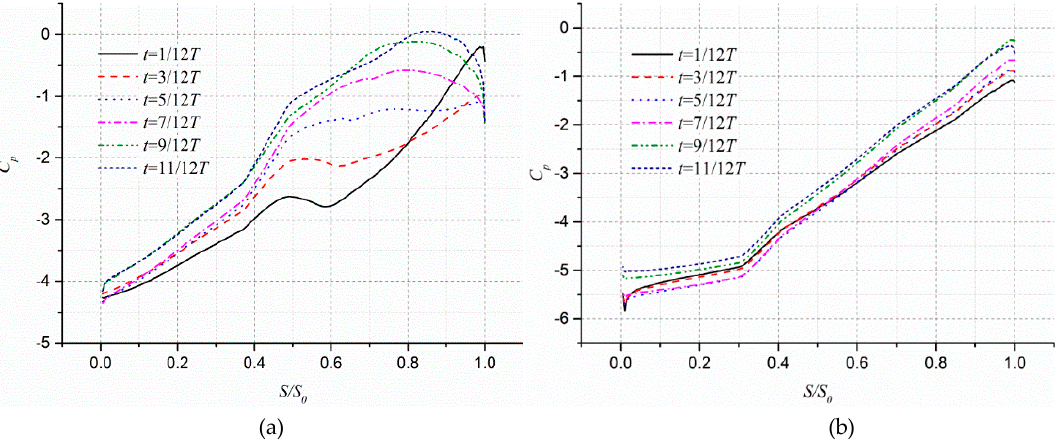
Figure 10. Distribution of the pressure coefficient on the blade surface for the Z / b 2 = 0.15 cross section: ( a ) pressure surface and ( b ) suction surface.